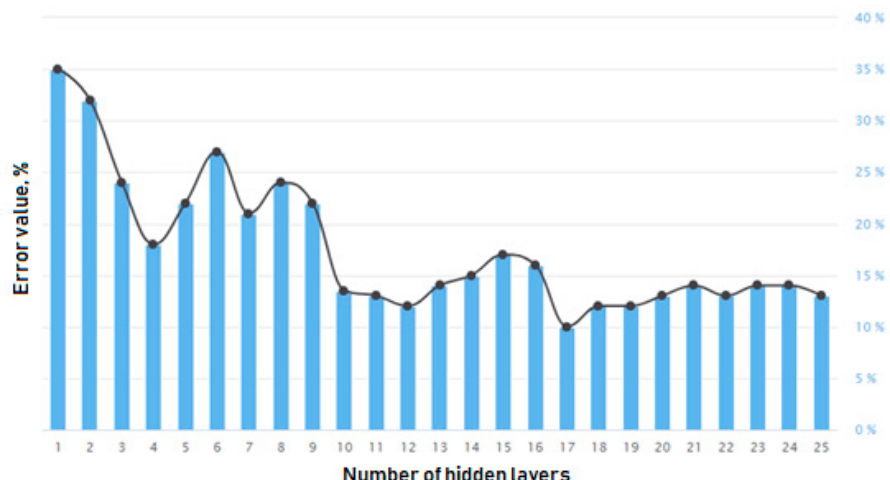
Figure 8. A chart of the ANN’s error value algorithm with the created structures.